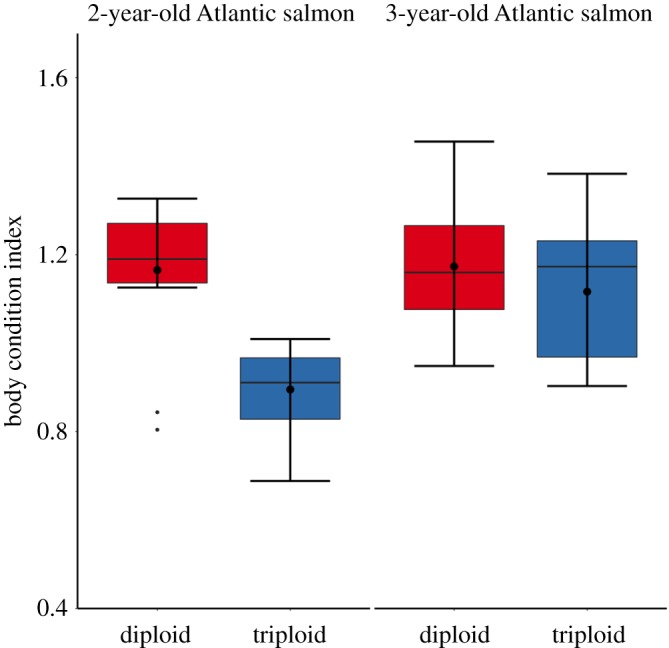
Body condition index of diploid and triploid farmed 2-year-old (n = 15 diploid; n = 15 triploid) and 3-year-old (n = 20 diploid; n = 20 triploid) Atlantic salmon reared in identical environments. Boxplots show median (horizontal black line) and mean (thick black dot); whiskers indicate points within the 1.5 IQR and quartile ranges (coloured box area).